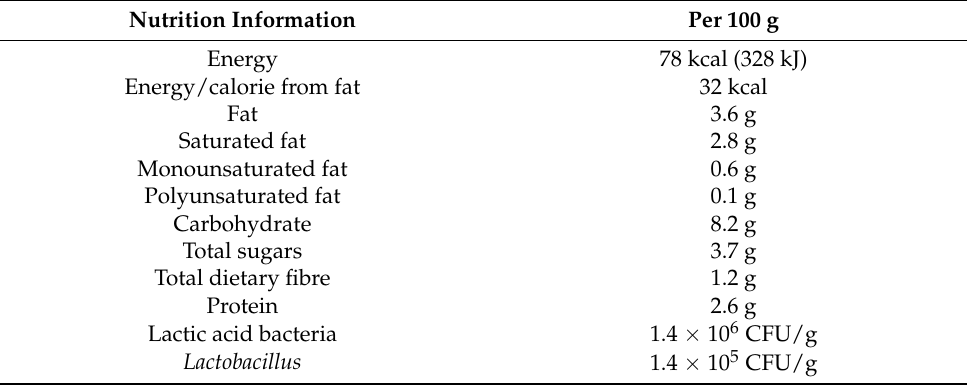
Table 1. Nutritional analysis of E. tapos